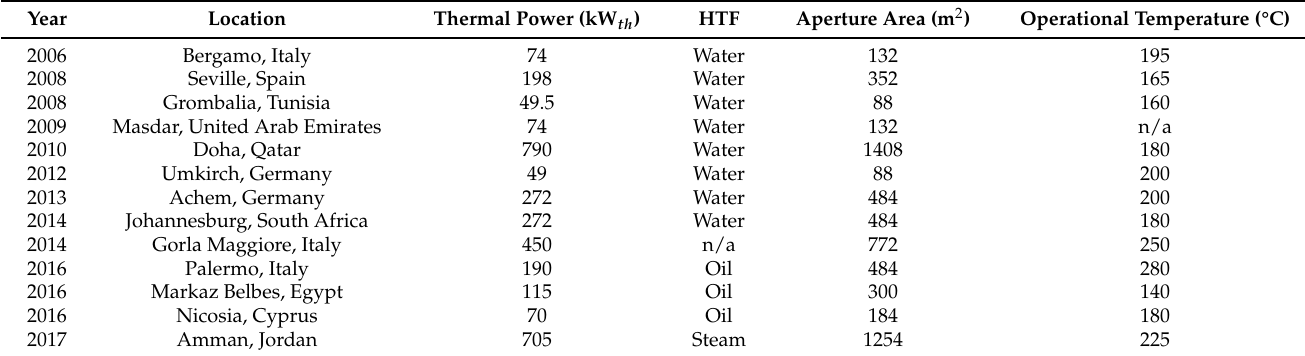
Table 1. List of operational and past facilities supplying cooling with the assistance of Linear Fresnel Reflector (LFR) technology